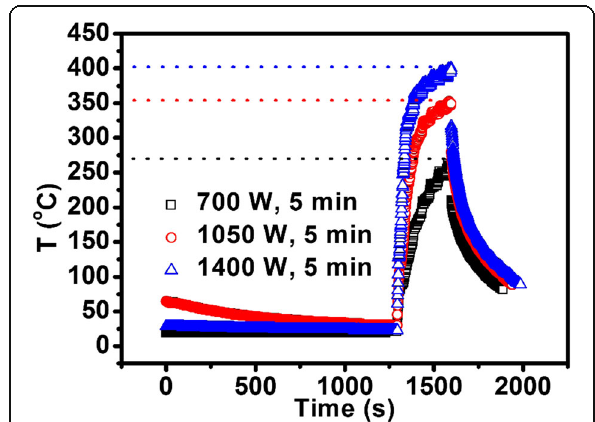
Fig. 4 a The plot of the leakage current density ( J ) vs bias and b the cumulative probability plot of the breakdown voltage for different